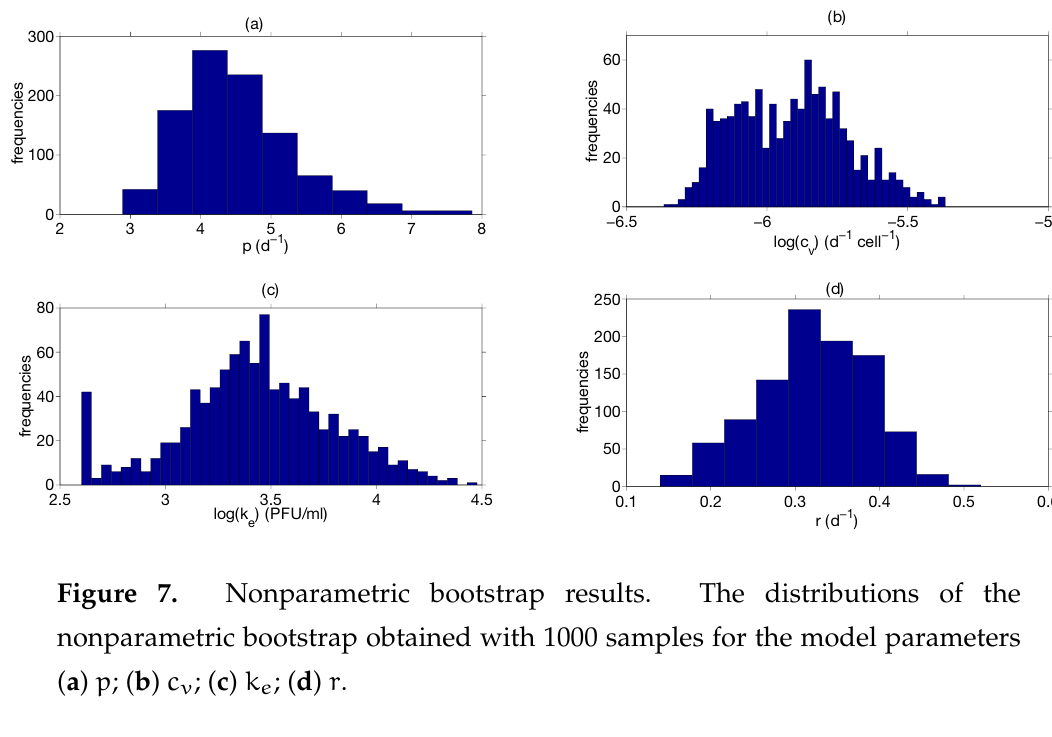
Figure 7. Nonparametric bootstrap results. The distributions of the nonparametric bootstrap obtained with 1000 samples for the model parameters ( a ) p ; ( b ) c v ; ( c ) k e ; ( d ) r .